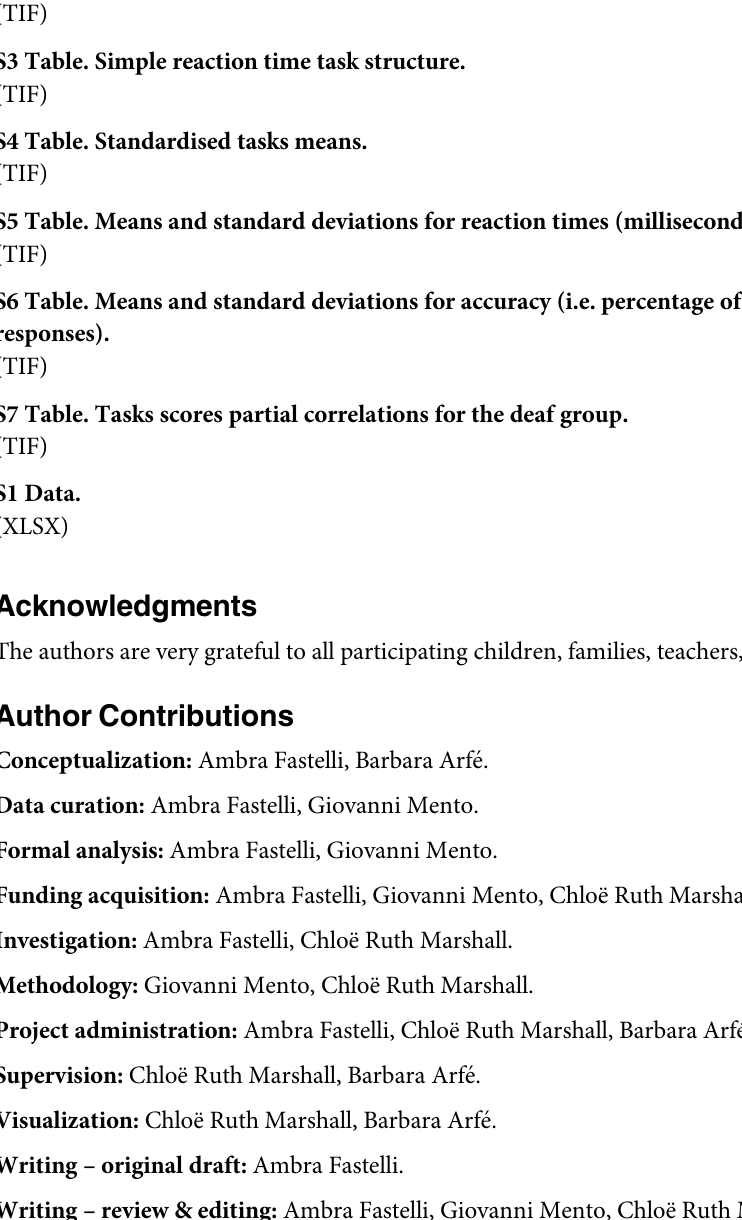
S1 Table. Participants’ linguistic background and parental socioeconomic status. S2 Table. Participants’ characteristics. S3 Table. Simple reaction time task structure. S4 Table. Standardised tasks means. S5 Table. Means and standard deviations for reaction times (milliseconds). S6 Table. Means and standard deviations for accuracy (i.e. percentage of not anticipated responses). S7 Table. Tasks scores partial correlations for the deaf